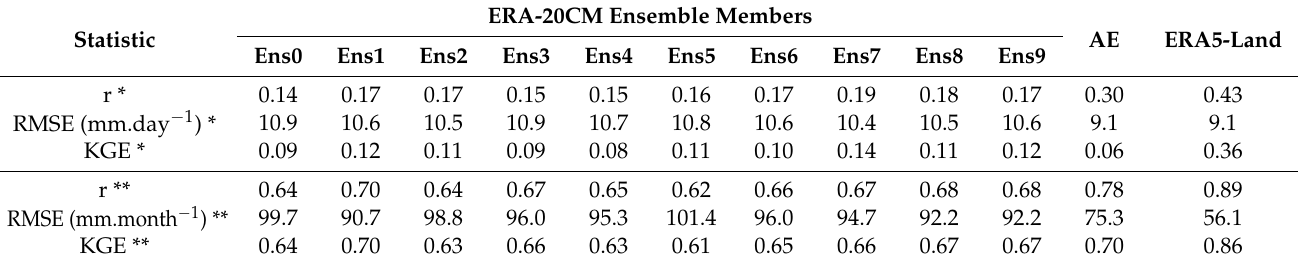
Table 2. Statistical results for the ten ERA-20CM ensemble members, AE, and ERA5-Land in daily (*) and monthly (**) time scales in the PRB, with N-value equal to 352 for monthly time scale and 10,725 for daily time scale and p -value =